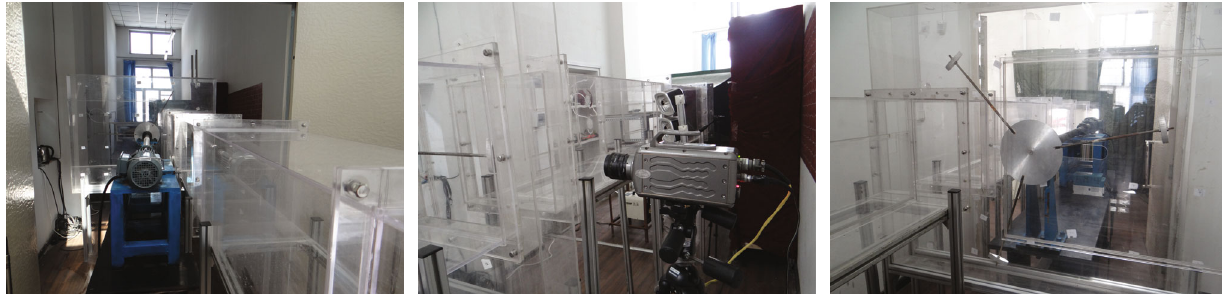
Figure 2: Images of the test system.